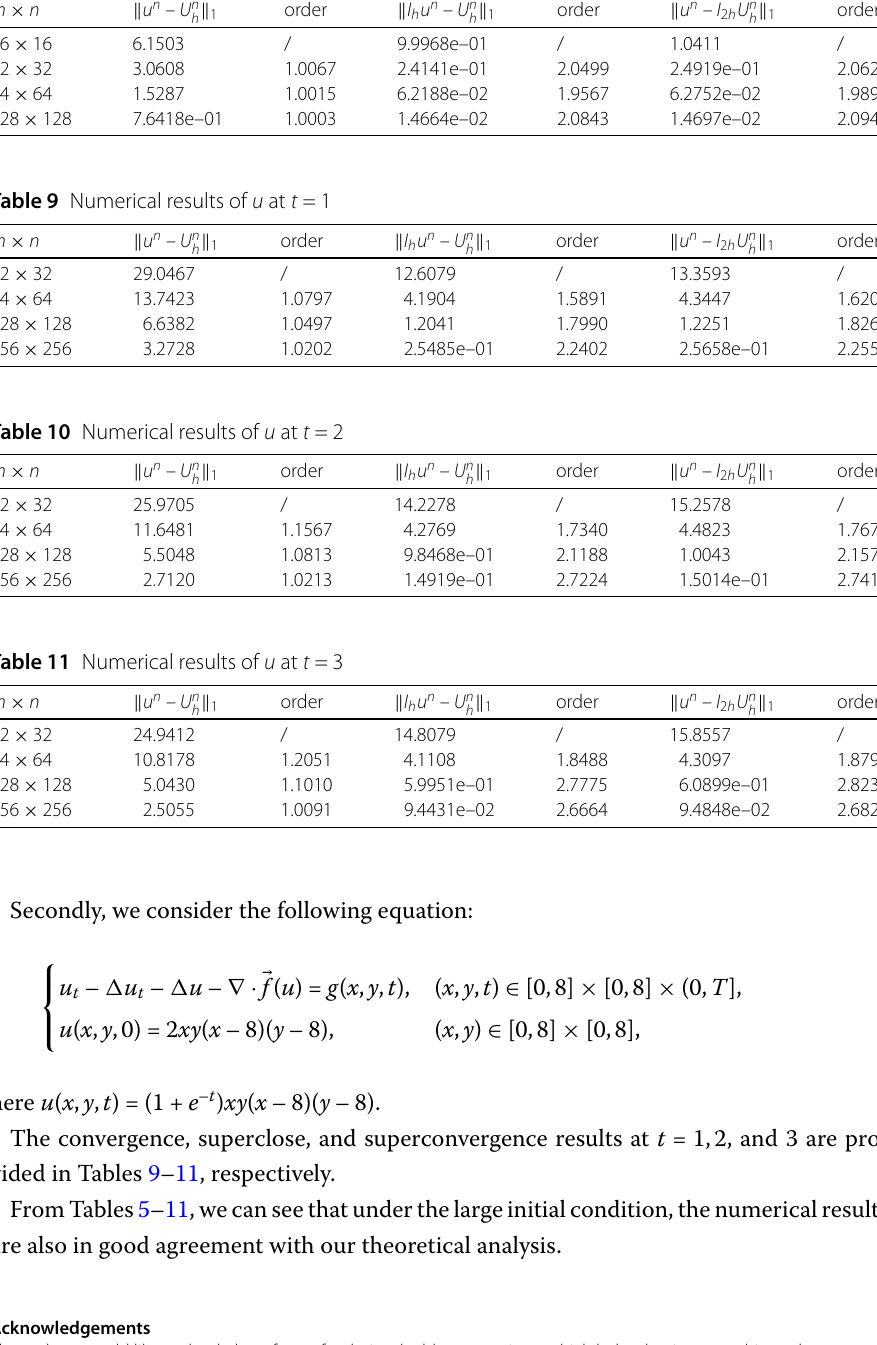
Table 8 Numerical results of u at t = 3 m × n